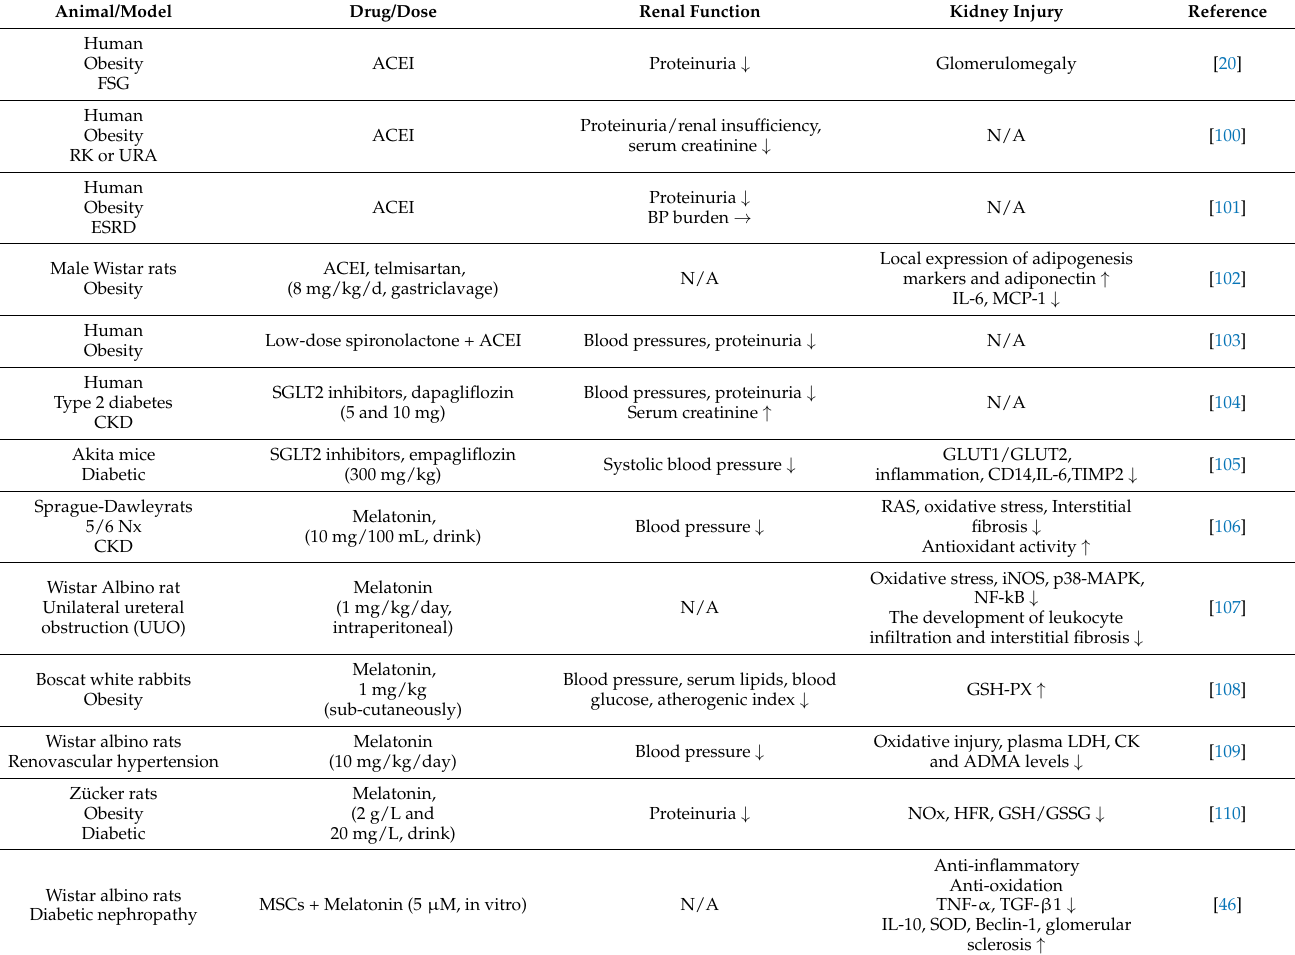
Table 2. Studies on the effects of different drugs on kidney injury and